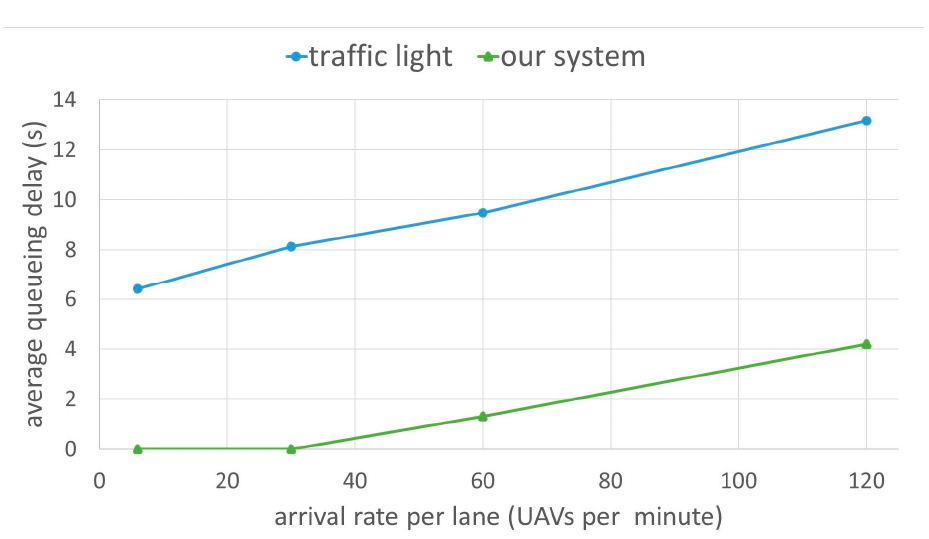
Figure 25. Average queueing delay of the UAVs using 2D optimal static traffic light and using our proposed system in 2D intersection on Scenario 1.